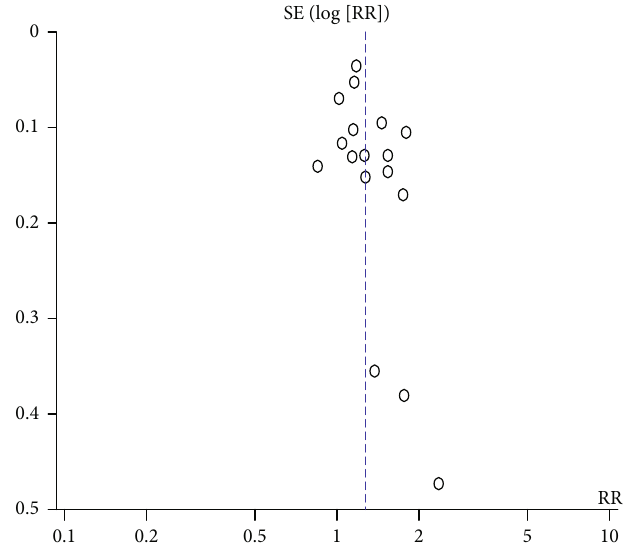
Figure 12: Funnel plots of publication bias for the association between LSD and